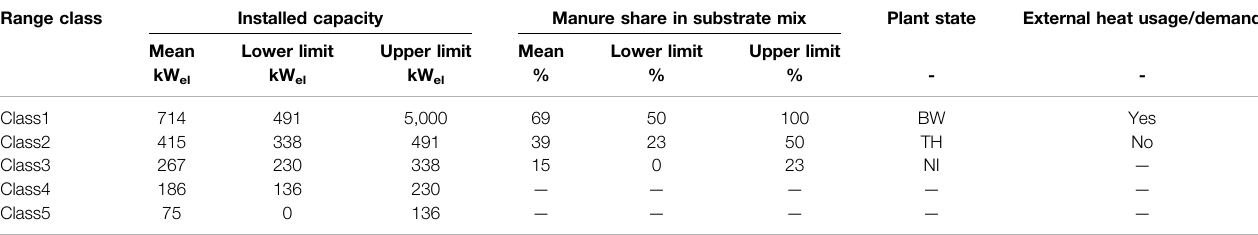
TABLE 3 | Characteristic parameter and range classes to determine representative plant clusters. Range class Installed capacity Manure share in substrate mix